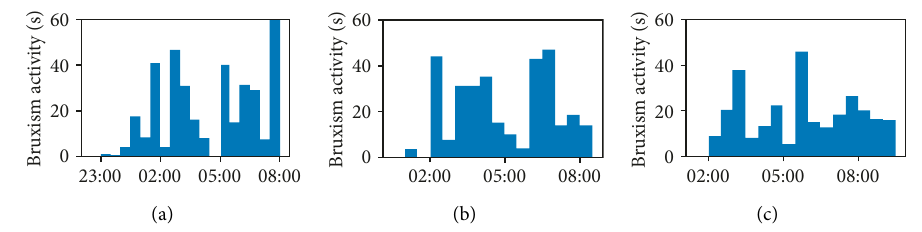
Figure 6: (a–c) Establishment of the baseline bruxism severity from 3 nights of recording without biofeedback.